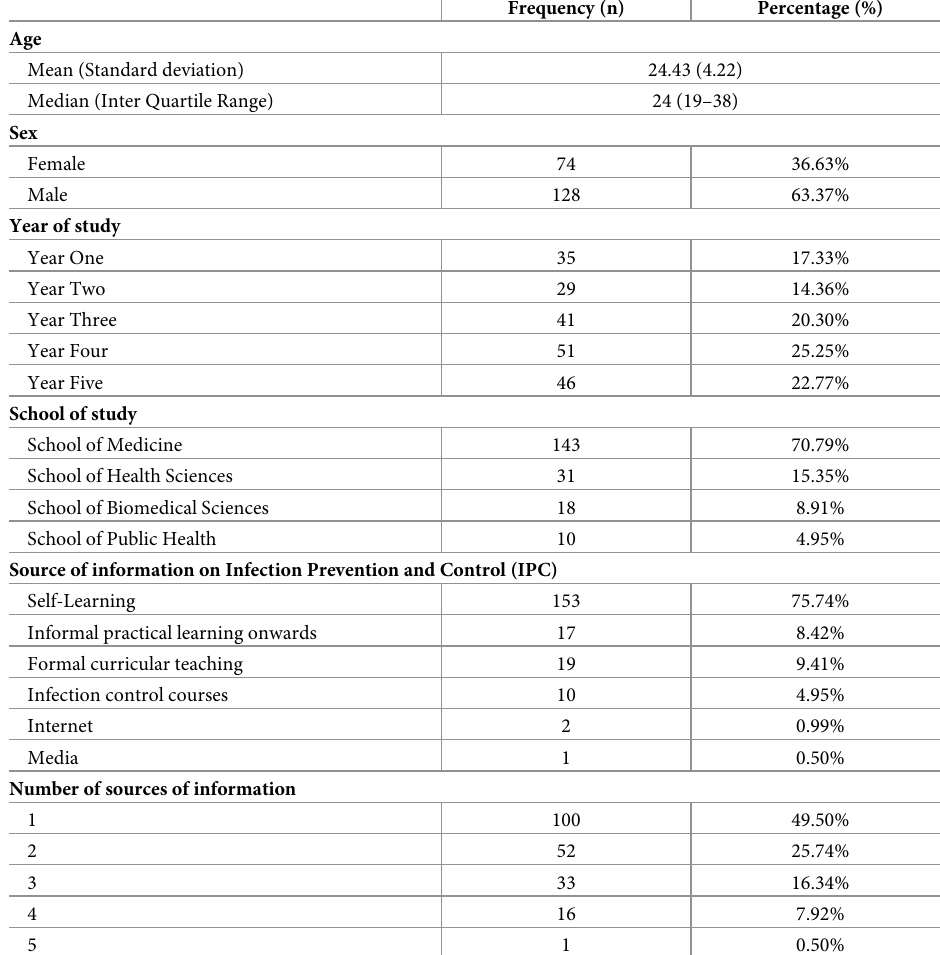
Table 1. Demographic characteristics of health professional students at Makerere University College of Health Sciences,